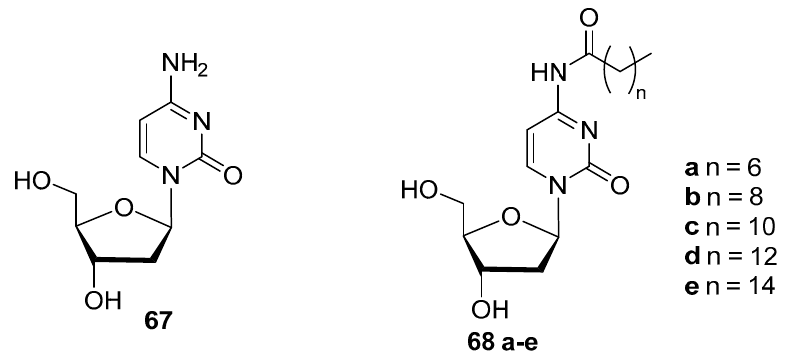
Figure 44. Cytosine and cytosine-based gelators [91,92].